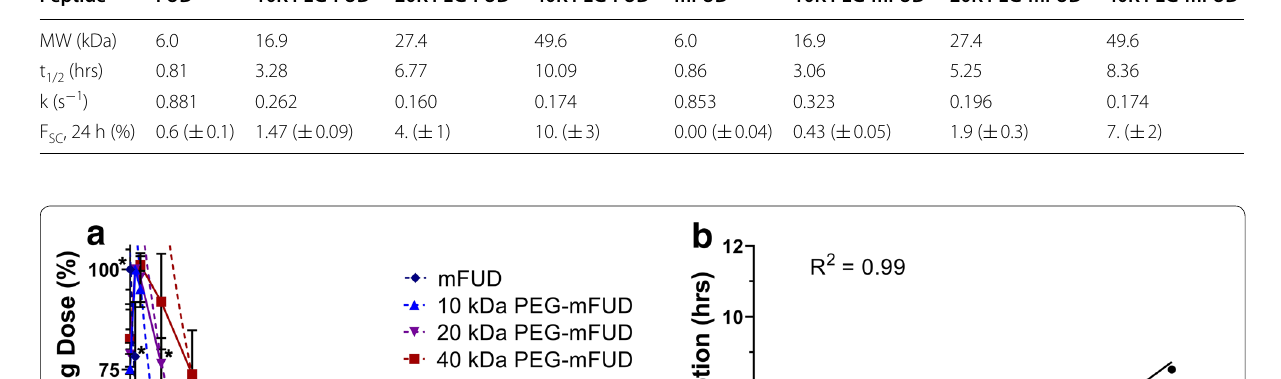
Table 2 Extracted drug s.c. absorption parameters Peptide FUD